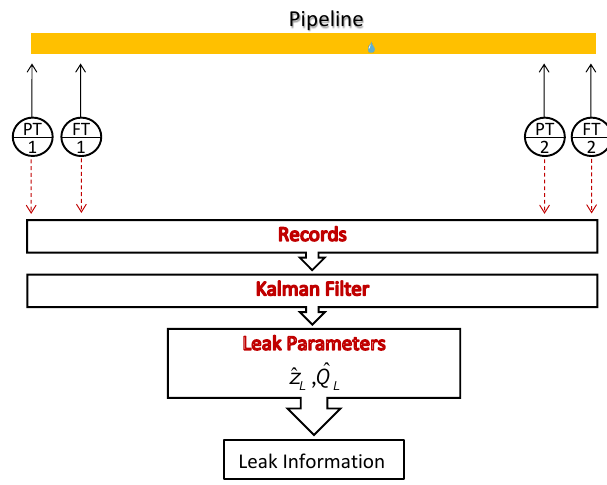
Figure 7. Architecture of approaches based on the direct estimation of the leak